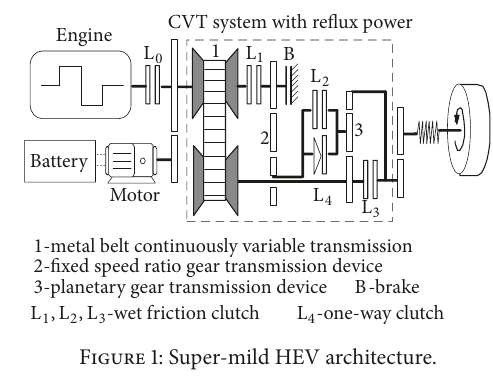
Figure 1: Super-mild HEV architecture.